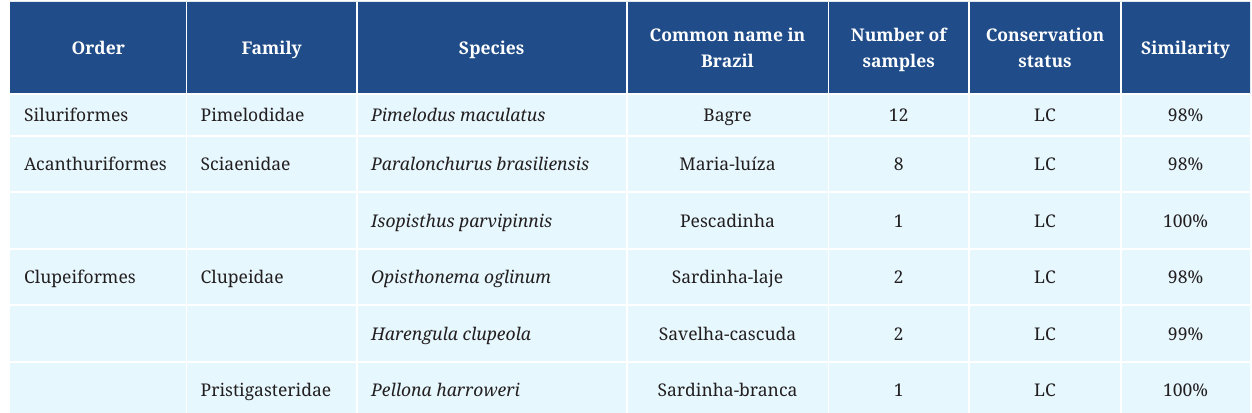
TABLE 1 | List of the prey fish species encountered in the stomach contents of the largehead longtail Trichiurus lepturus , identified by DNA mini-barcoding